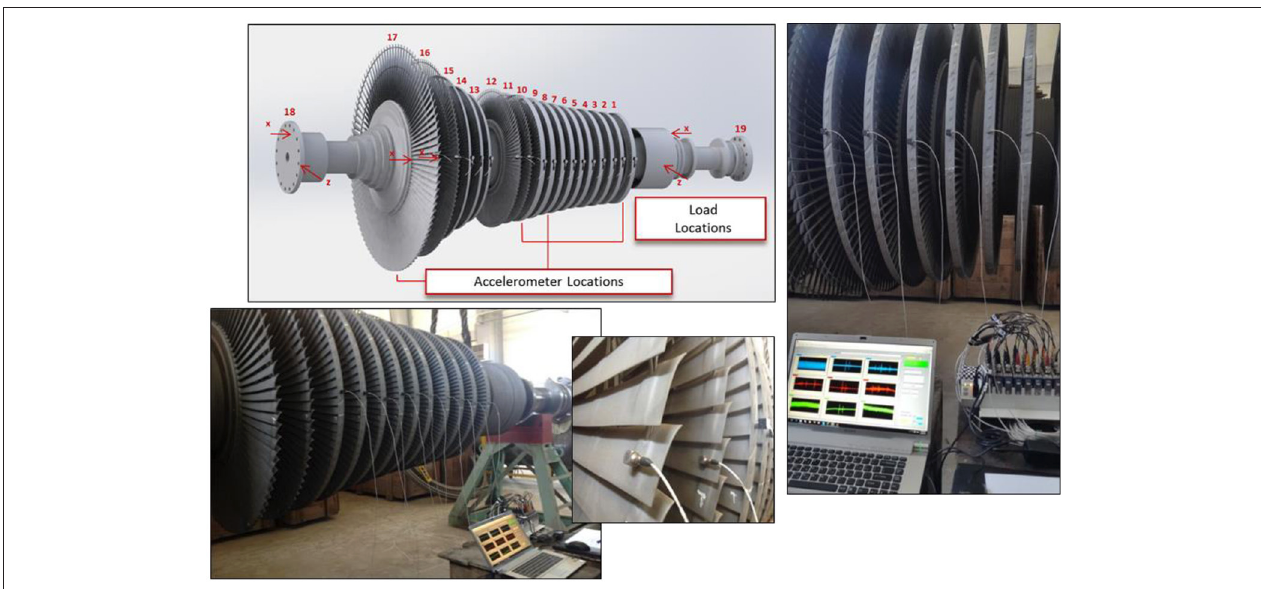
FIGURE 7 | Experimental set-up of the intermediate pressure turbine.